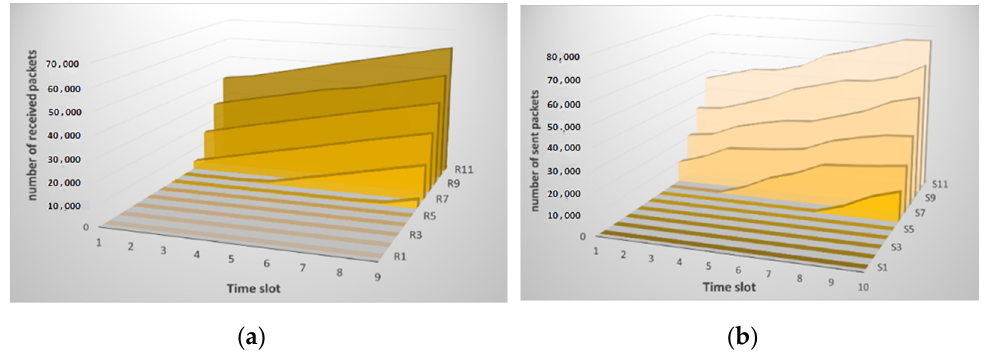
Figure 9. Changes in the traffic pattern when analyzing raw data on: ( a ) received packets from node i ; and ( b ) sent packets from node i under conditions of a SYN flood attack.